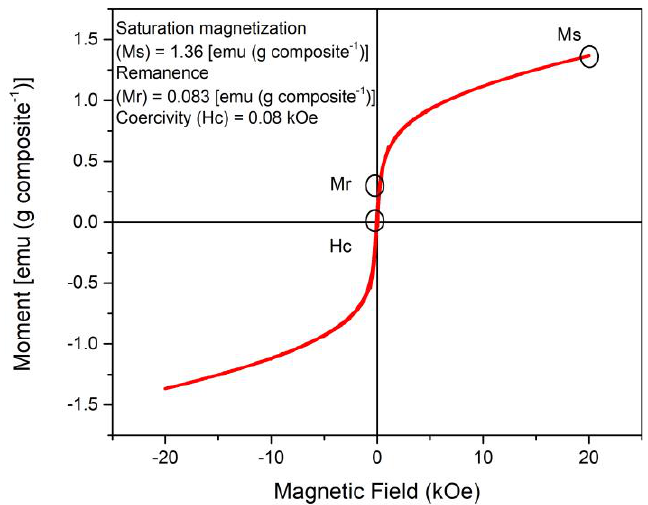
◦ 3 O 4 @ Sargassum @EDTA at ~28